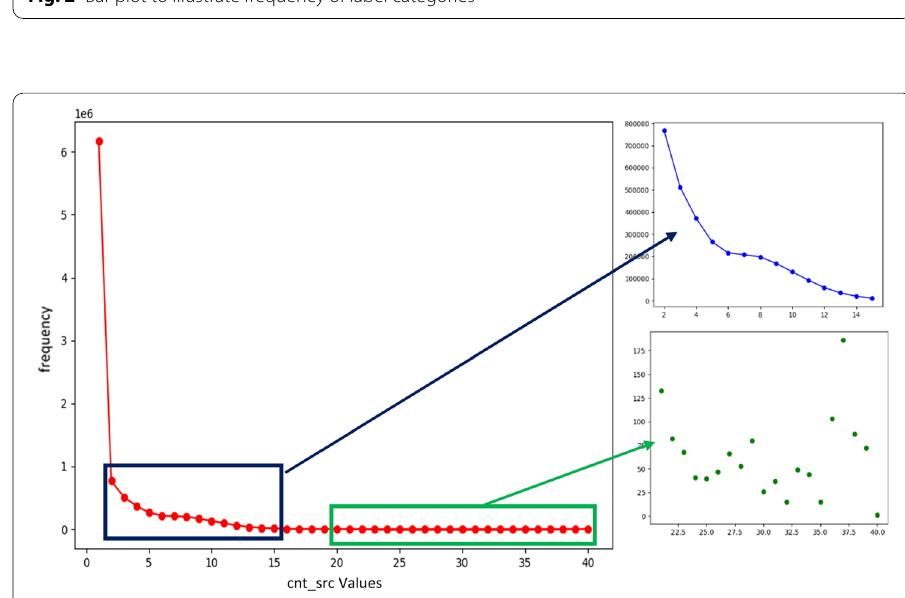
Fig. 2 Bar plot to illustrate frequency of label categories